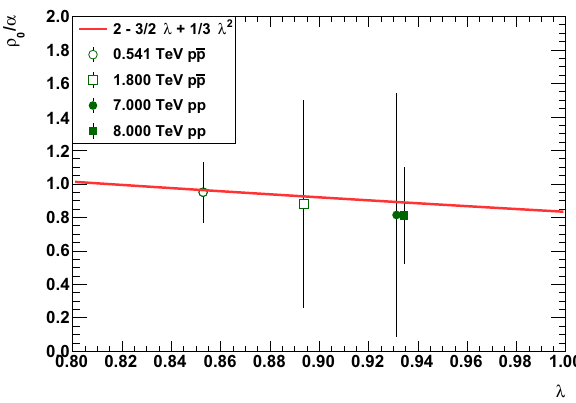
Fig. 7 Thedependenceof ρ 0 /α on λ intheTeVenergyrange.Thedata points are generatednumericallyby using the trends of the ReBBmodel parameters, R q , R d , R qd , shown in Fig. 6a–c and the experimentally measured ratio ρ 0 values. The red curve represents the result of the analytical calculation showing a good agreement with the numerical calculations